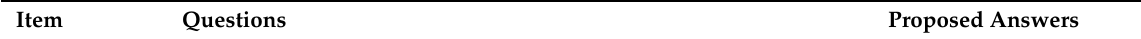
Table 1. Questions and proposed